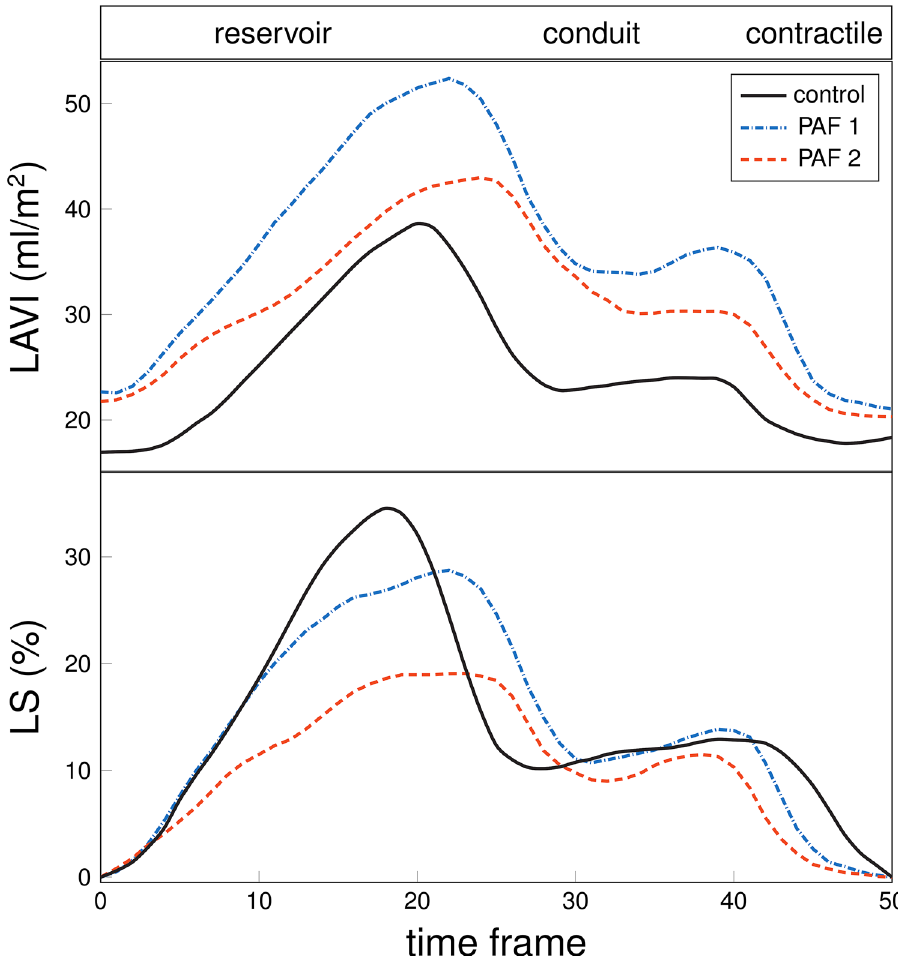
Figure 3. Example of indexed left atrium volume (LAVI) and longitudinal strain (LS) measurements. Example of the LAVI (upper panel) and LA LS (lower panel) measured with CMR-FT in a control subject and